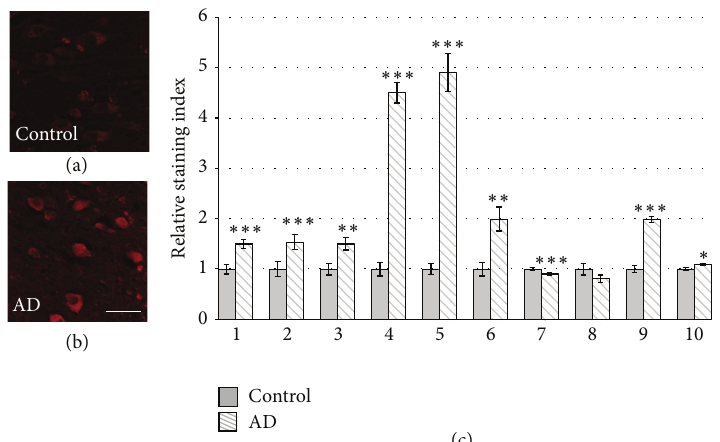
Figure 2: Aromatase expression was higher in the hippocampi of brains from patients with AD than in control brains . (a, b) Immunohisto- chemical staining in the CA4 region of postmortem hippocampi from a patient diagnosed with AD (b) and a sex- and age-matched control (a) (scale bar: 20 𝜇 m). (c) Semiquantitative analysis of aromatase immunoreactivity, expressed as the relative staining index, demonstrated that in most cases aromatase reactivity was higher in the hippocampi obtained from AD brains than in the sex- and age-matched control hippocampi. The numbers for each matched pair refer to Table S1 (sample numbers 1–10) ( ∗ 𝑝 ≤ 0.05 , ∗∗ 𝑝 ≤ 0.01 , ∗∗∗ 𝑝 ≤ 0.001 ; bars represent mean ± SEM).